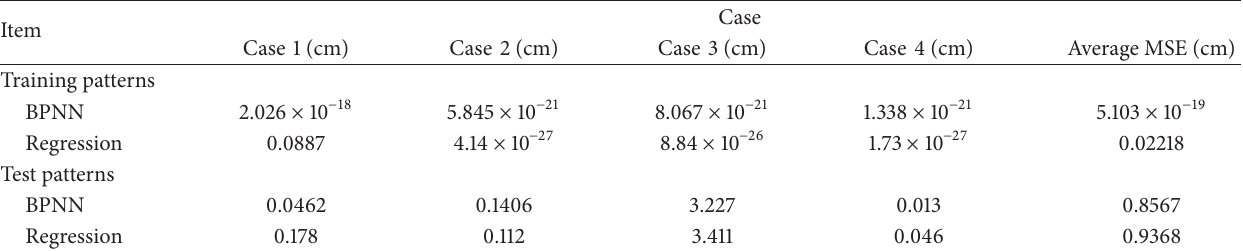
Figure 8: Representative shock test results. Table 3: MSE of heights by BPNN and regression analysis.